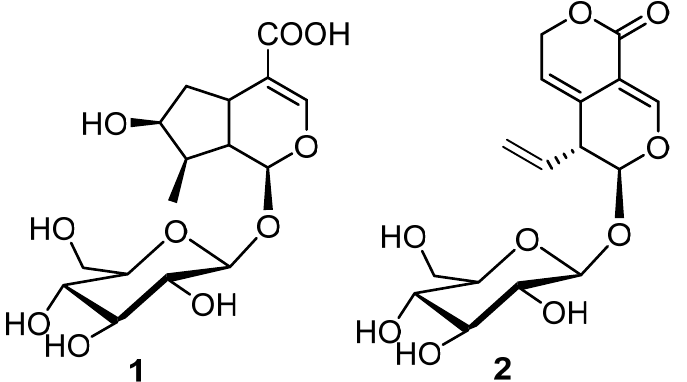
Figure 1. Molecular structure of loganic acid ( 1 ) and gentiopicroside ( 2 ).